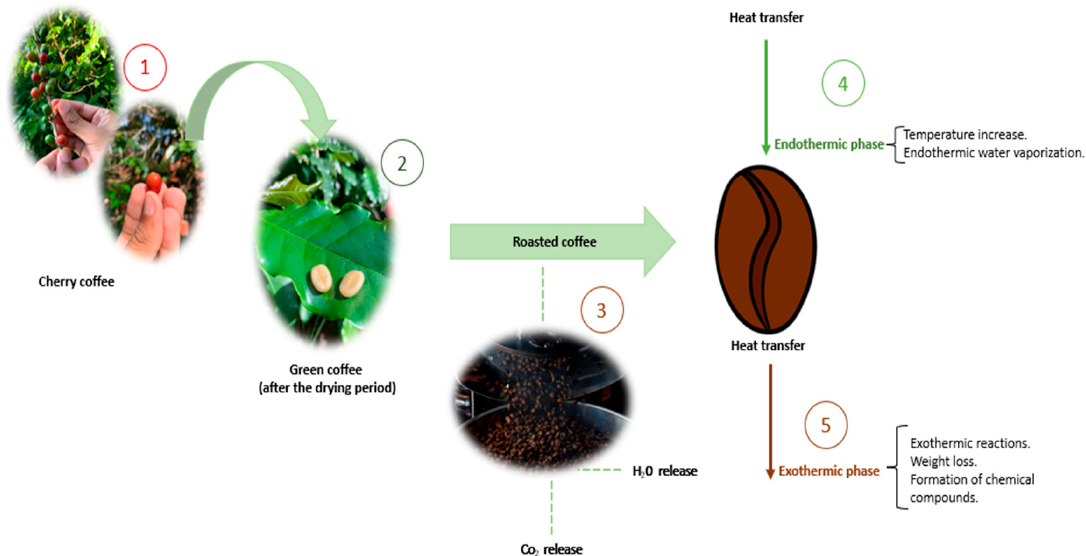
Figure 3. Coffee roasting (authorial). 1: cultivation by hand; 2: drying; 3: roasting; 4: endothermic phase of the roasting; 5: exothermic phase of the roasting.